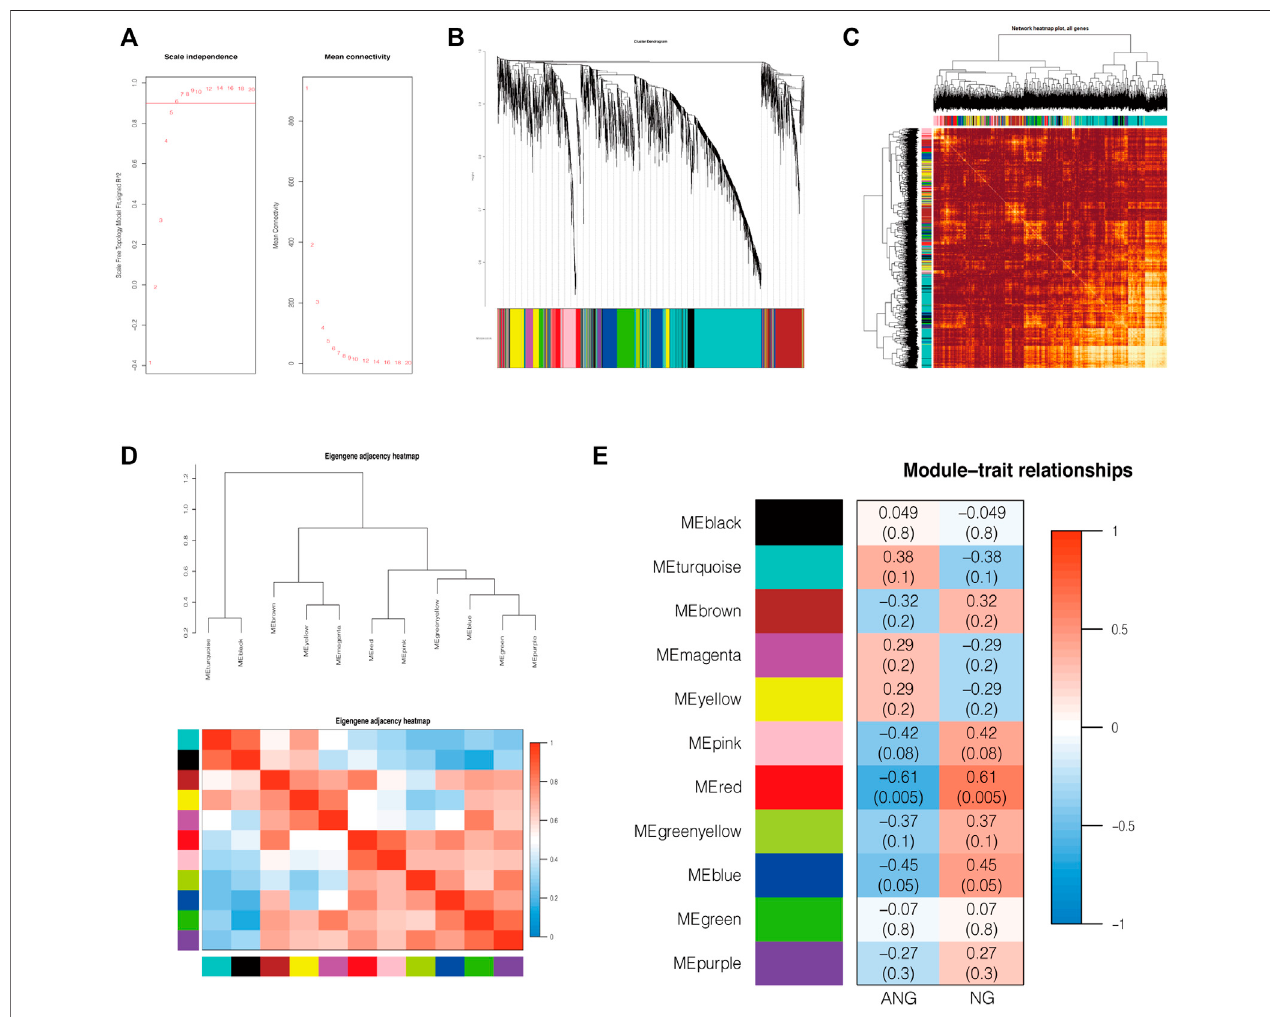
FIGURE 2 | Construction of co-expression modules by WGCNA. (A) The relatively balanced scale independence and mean connectivity in Scale-free topology analysis. The power value was 6, which was the lowest power for the scale-free topology fi t index of 0.9. (B) Construction of co-expression modules by the WGCNA package through R. Genes are represented by branches, and co-expression modules are shown in different colors below in fi gure. (C) Network heatmap of the interaction relationship of different modules. (D) Eigengene adjacency heatmap plot of different modules. (E) Heatmap of the correlation between module eigengenes and the disease status of EAS. The red module was the most negatively correlated with status. NG: normal endothelial function groups; ANG: abnormal endothelial function groups.